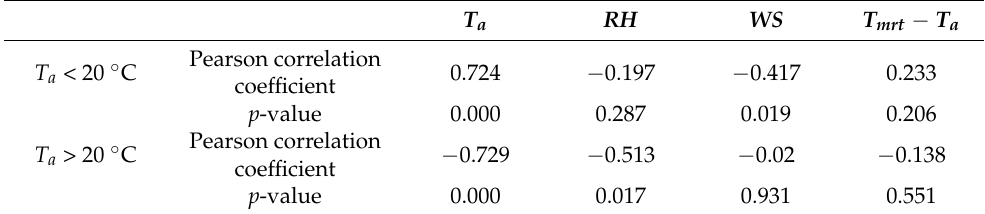
Table 2. Pearson correlation coefficients for different environmental parameters and attendance. T a RH WS T mrt − T